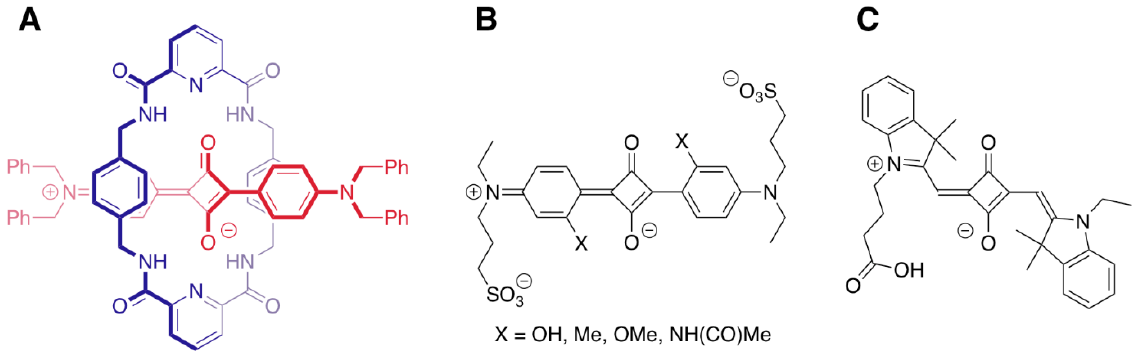
Figure 7. Squaraine dyes with reduced reactivity towards thiol nucleophilic attack on the squaraine’s electrophilic center. ( A ): a representative example of squaraine rotaxane [116]; ( B ): ortho-substituted squaraines [119]; ( C ): symmetric arylidene squaraine [120].